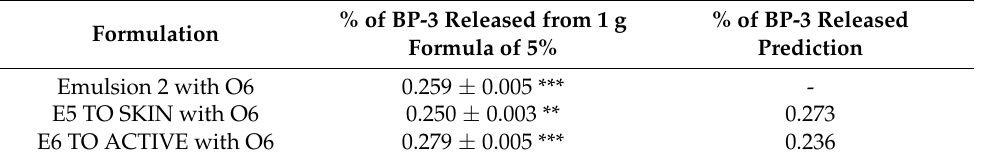
Table 13. Percentage release of BP-3 from emulsions E2, E5 and E6 containing O6 (C12-C15